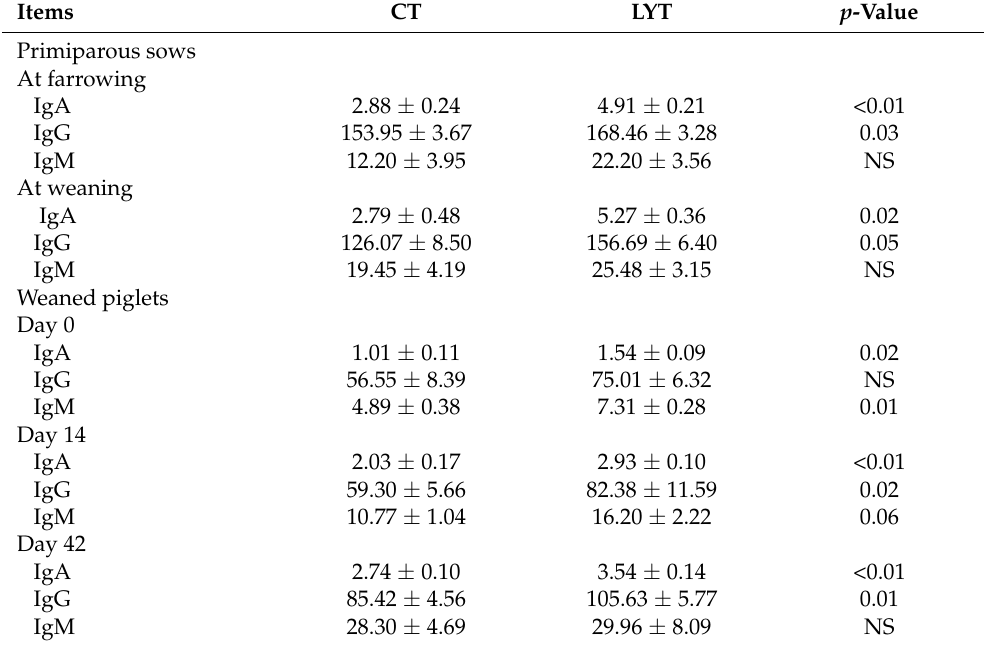
Table 7. The effects of live yeast supplementation during middle–late pregnancy and lactation period on serum immunological parameters (mg/mL) in primiparous sows and weaned